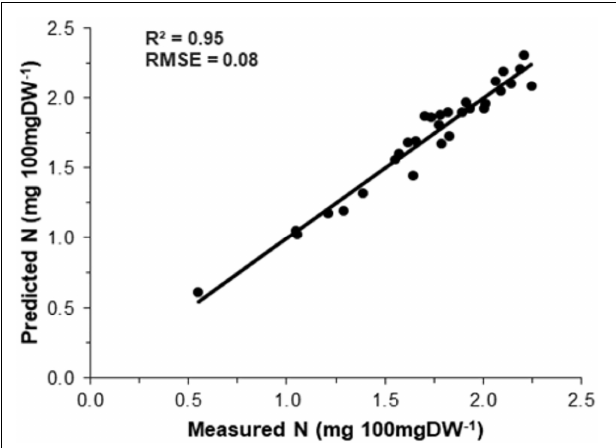
FIGURE 4 | Relationship between measured and predicted nitrogen concentrations in menthol mint.